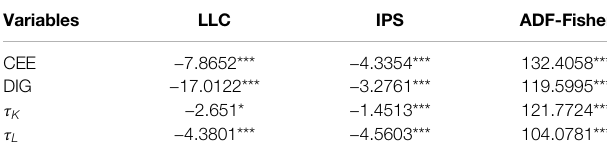
TABLE 8 | In fl uence mechanism results. TABLE 9 | Unit root test